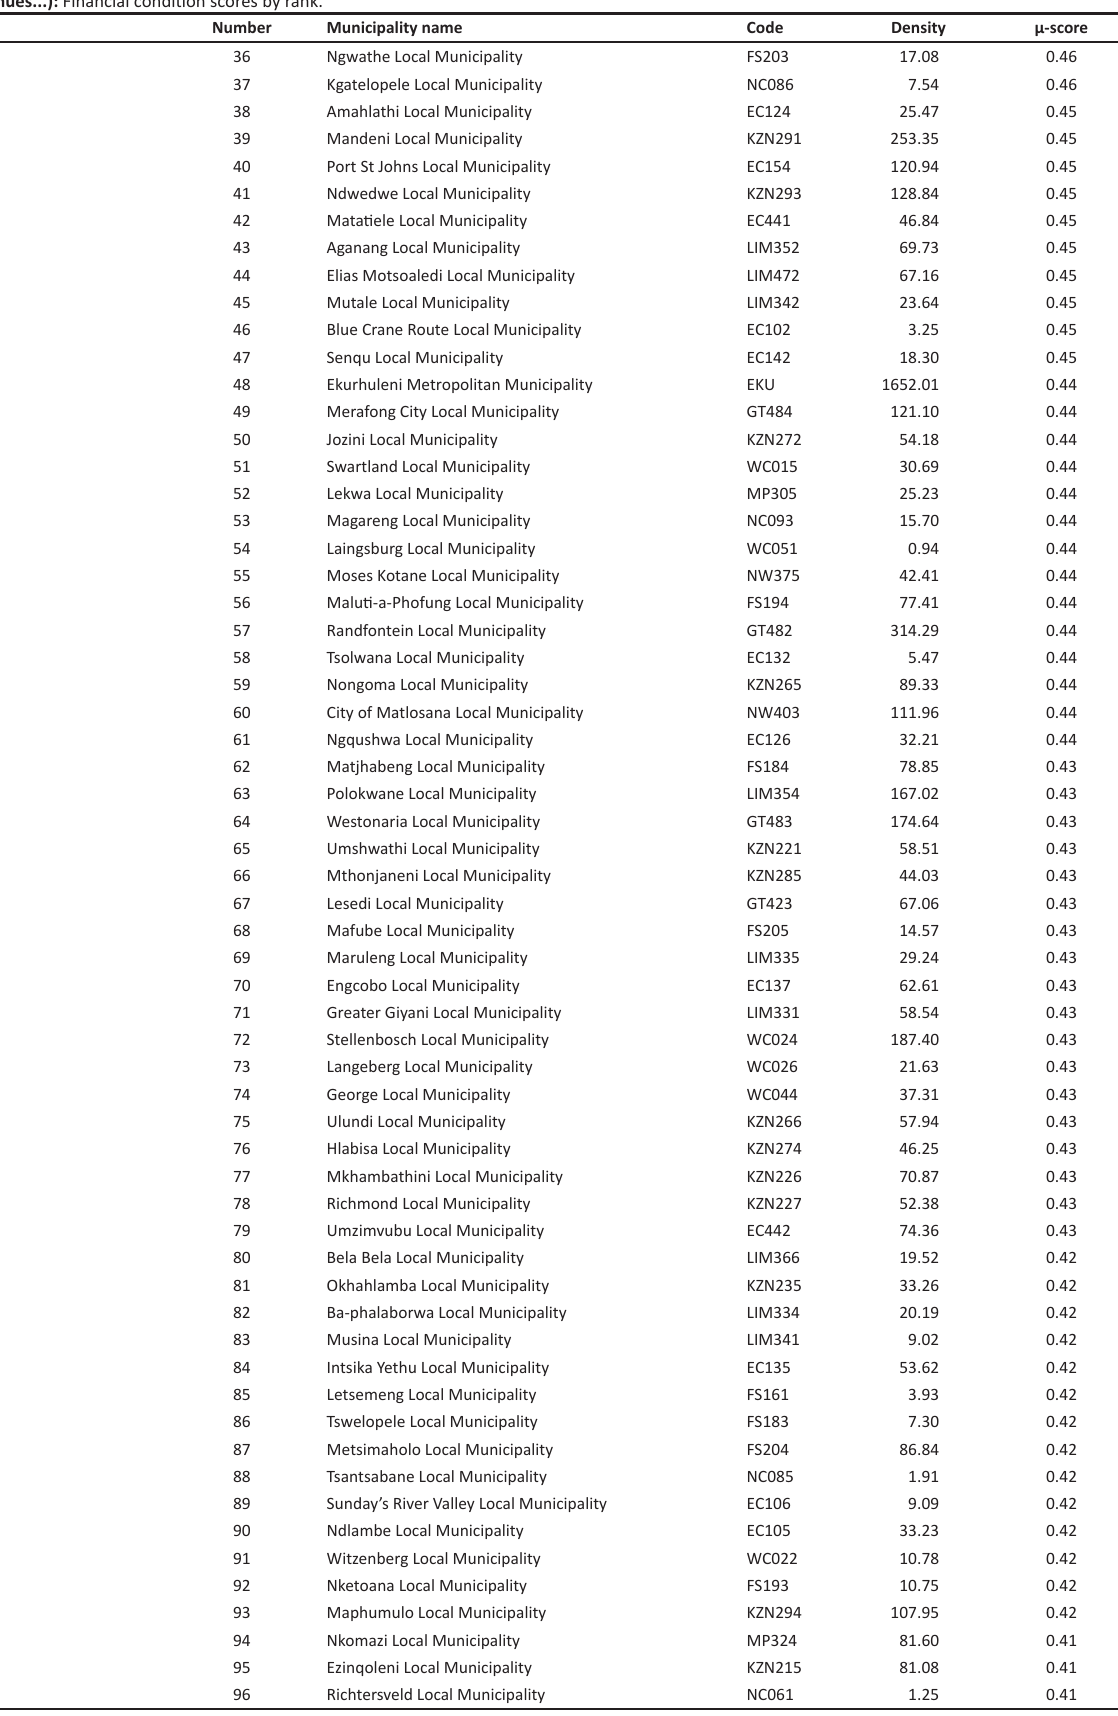
TABLE 1-A1 (Continues...): Financial condition scores by rank.